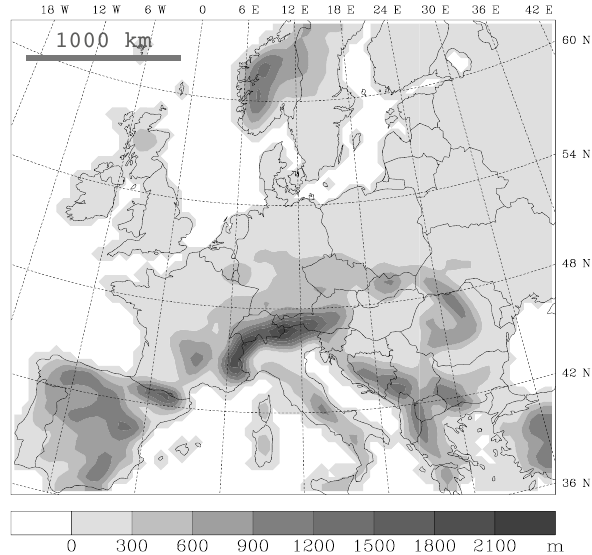
Fig. 3. Model domain and model topography of the regional climate model MM5 (for this illustration topography is interpolated from 45 × 45km spatial